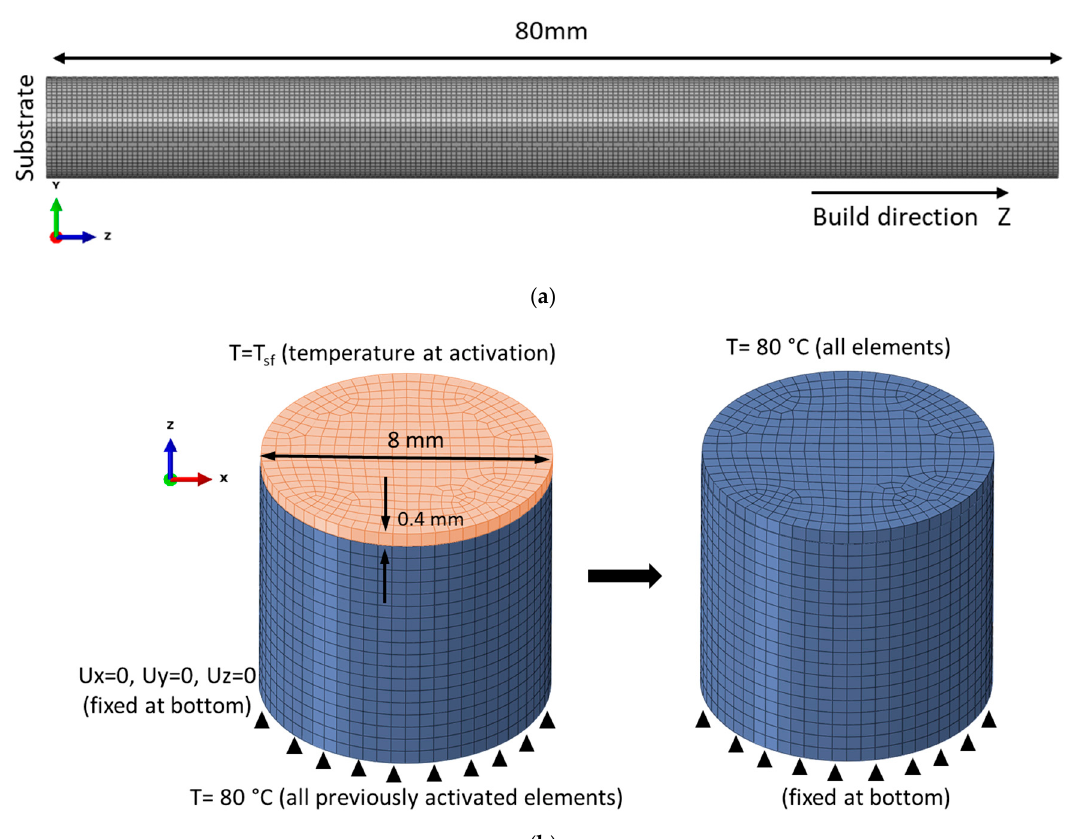
Figure 8. ( a ) Mesh of the cylindrical specimen built in vertical direction, ( b ) scheme of elements activation and boundary conditions.